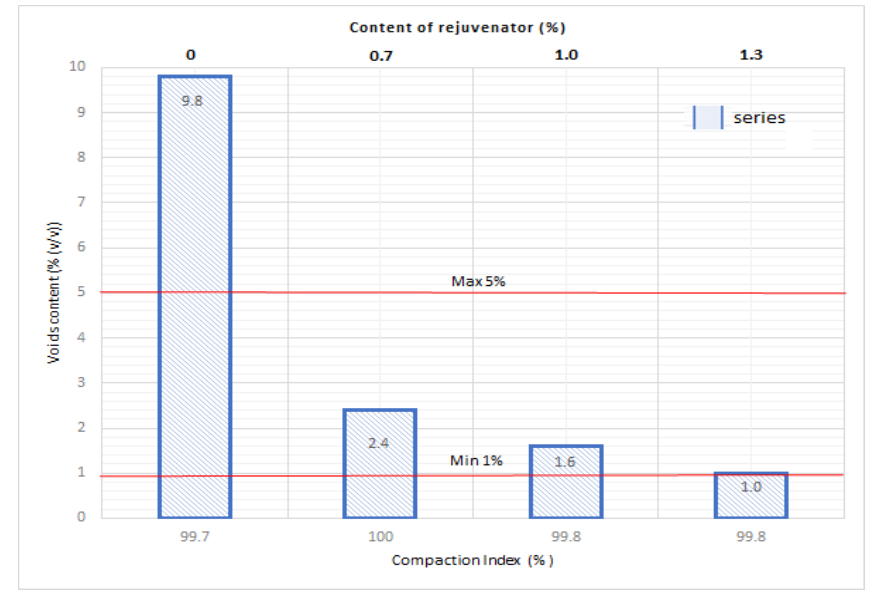
Figure 11. Voids content and compaction index of AM-100% in relation to the rejuvenator content.